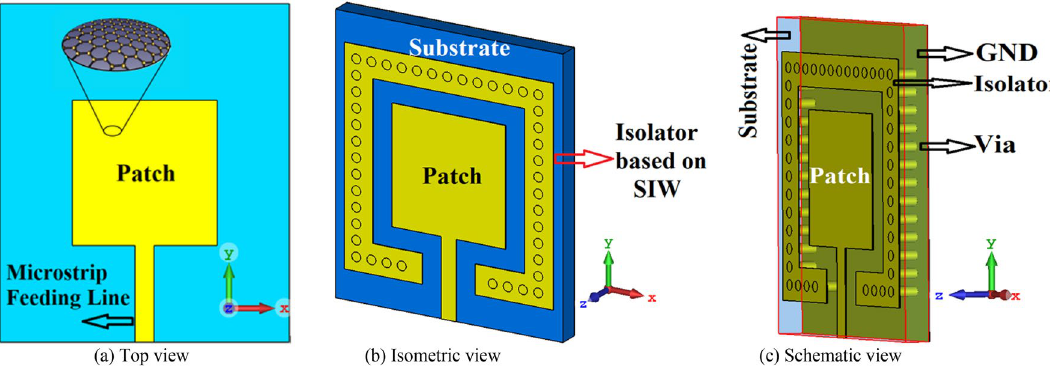
Figure 1. Antenna structure: ( a ) reference antenna with no SIW technology, ( b ) and ( c ) the proposed antenna with SIW technology.